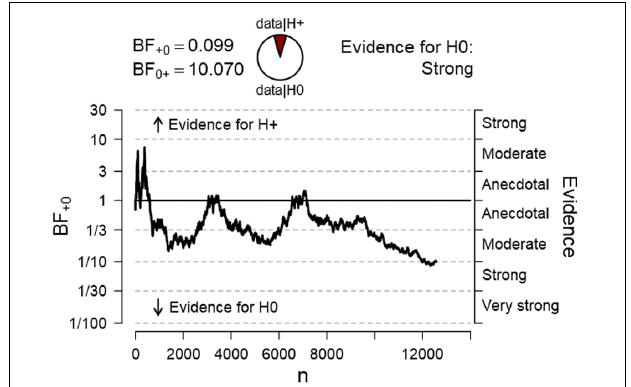
FIGURE 2 | Sequential Bayesian one-sample t -test analysis of the percentage of positive pictures across all 12,529 participants.